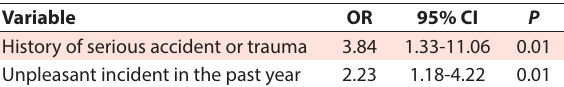
Table 2. The relationship of demographic and baseline factors of the studied population with personality disorders based on multivariate logistic regression analysis